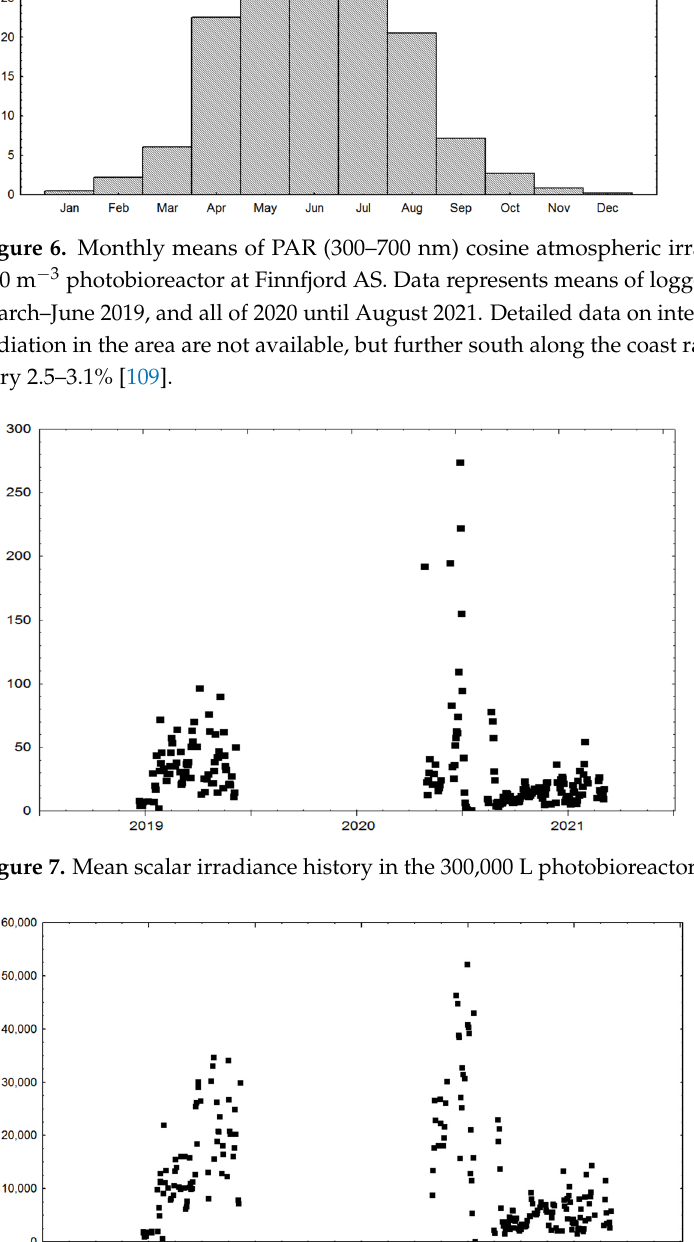
Figure 8. Total scalar light on–in the 300,000 L photobioreactor.